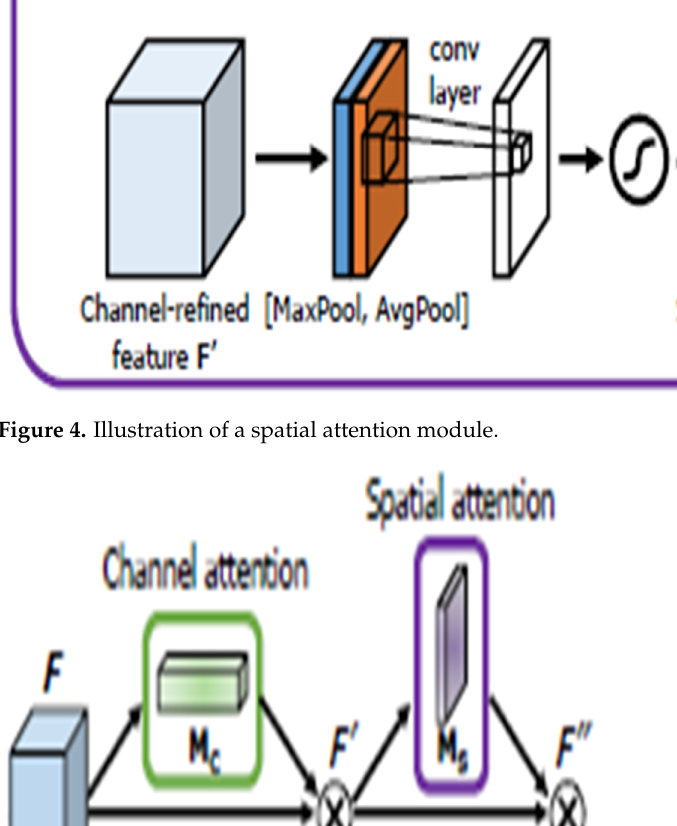
Figure 5. Illustration of a convolutional block attention module (CBAM).